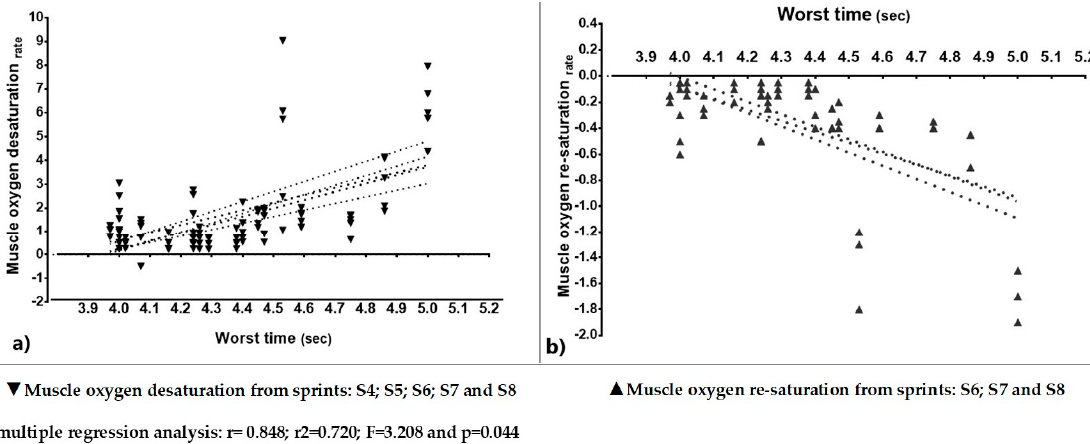
Figure 3. Association between the desaturation and re-saturation rates with the sprint time.